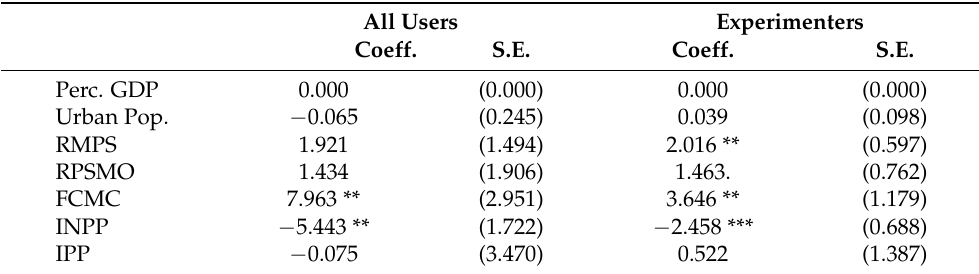
Table 6. Estimated association between cannabis policy reforms and changes in lifetime prevalence of all cannabis users and experimental users.